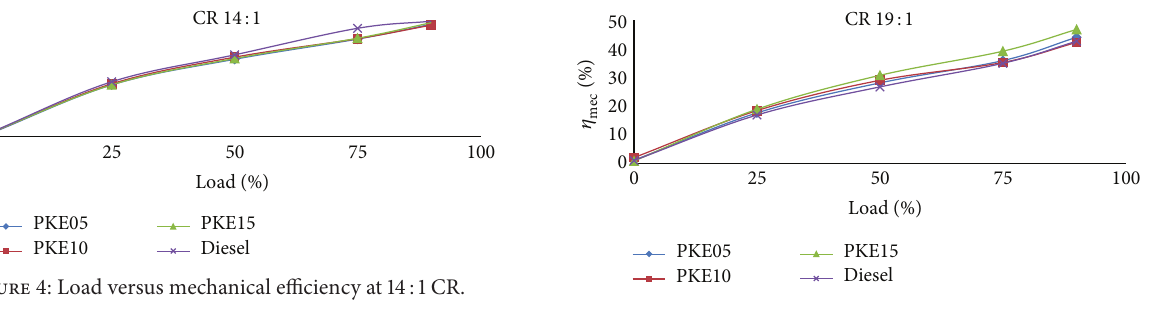
Figure 6: Load versus mechanical efficiency at 19: 1 CR.